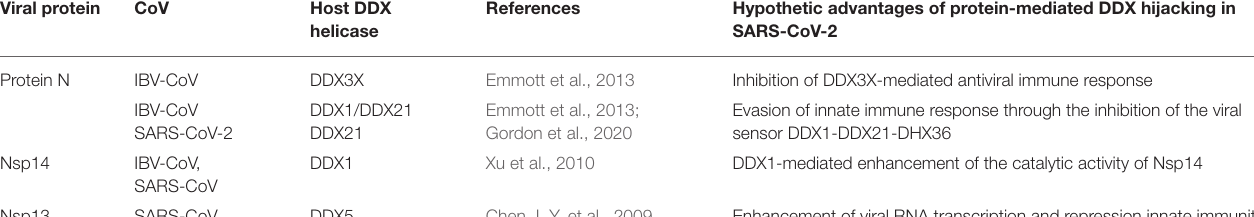
TABLE 1 | Viral proteins known to interact with host DDX helicases in CoVs. Viral protein